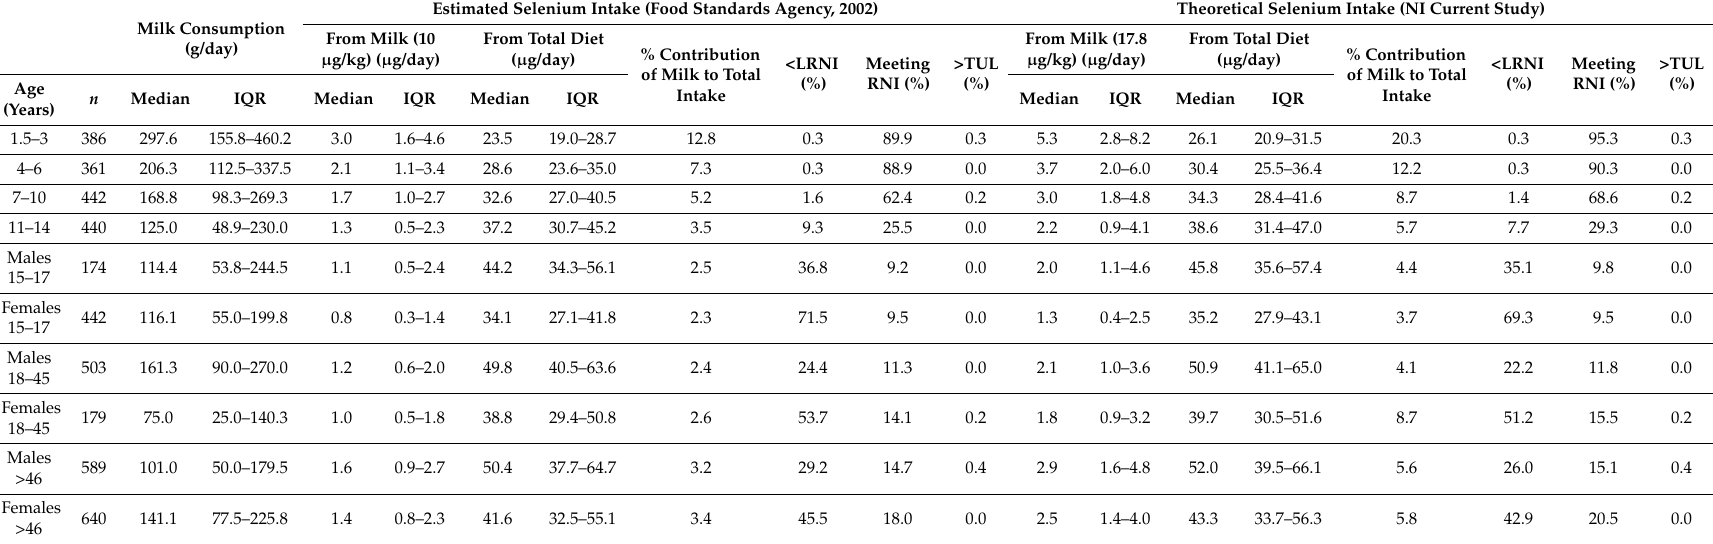
Table 3. Estimated selenium intake using National Diet and Nutrition Survey (NDNS) milk consumption data at selenium concentrations reported by the Food. Standards Agency (2002) [23] and those measured in the present study of NI